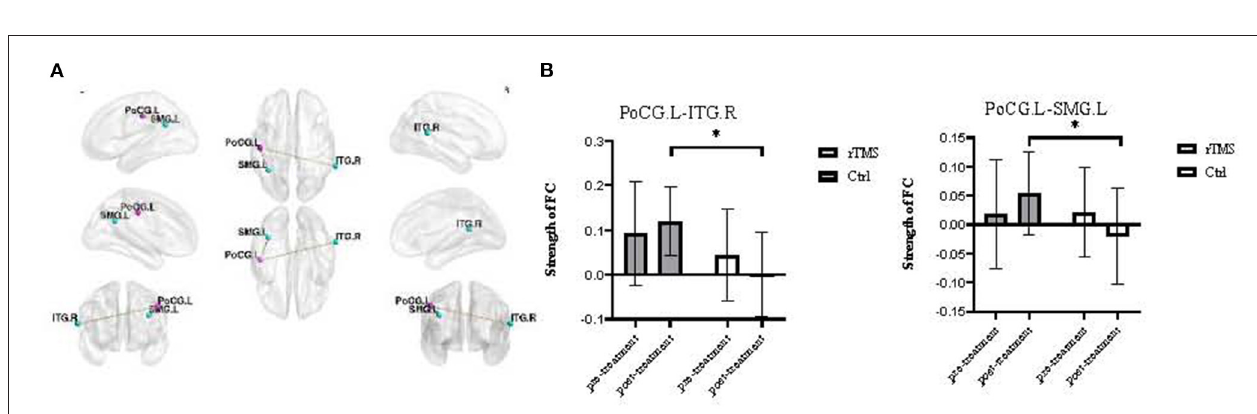
the control group ( p = 0.067), while the ratio was positively correlated with the correct responses rate on the WCST ( r = 0.296, p =